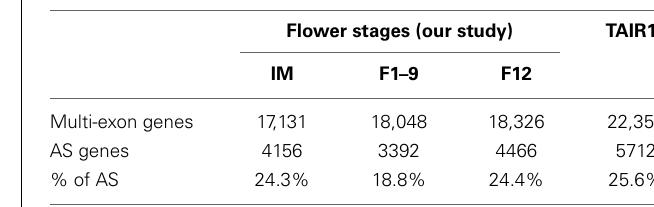
Table 2 | Estimation of alternatively spliced genes of the three